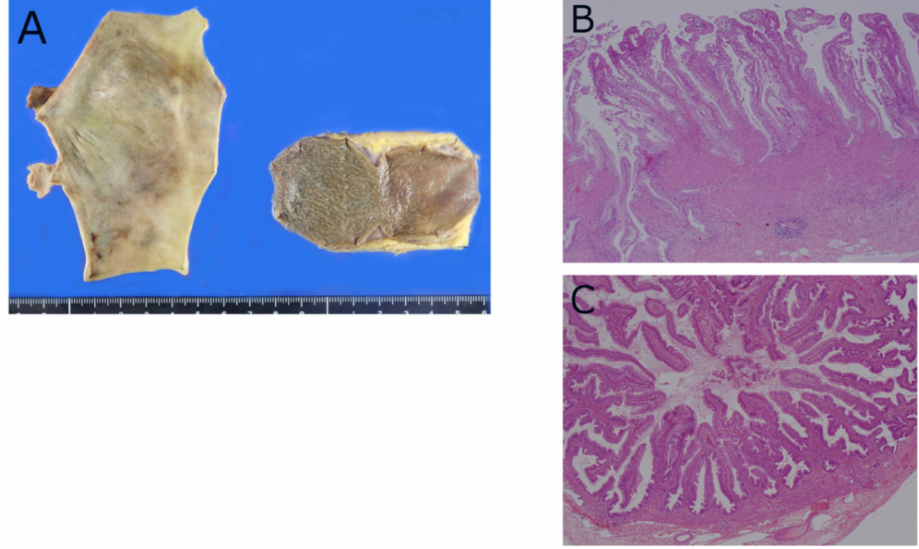
Figure 4. Pathology of gallbladders of patients with pancreatobiliary maljunction (PBM). ( A ) Resected specimens (prophylactic surgery) of gallbladder (right) and dilated bile duct (left). ( B ) Gallblad- der mucosa shows diffuse papillary hyperplasia. ( C ) Diffuse papillary hyperplasia observed in gallbladder of 2-year-old girl with PBM. ( B , C ) Hematoxylin and